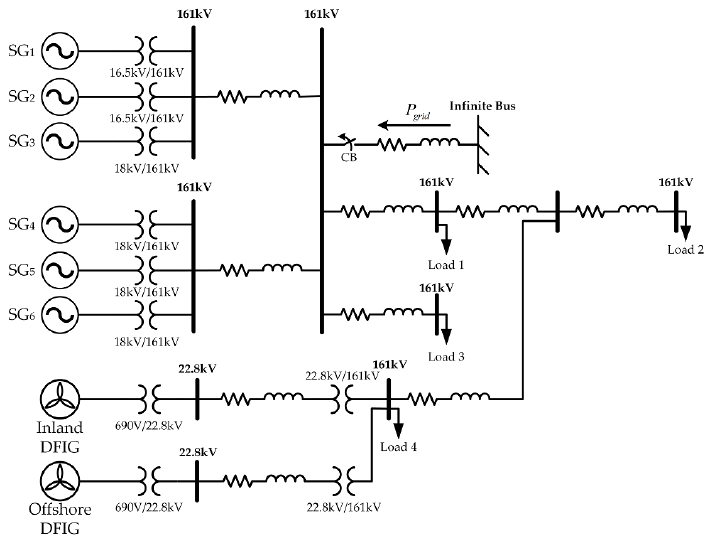
Figure 1. One-line diagram for the studied local power system.